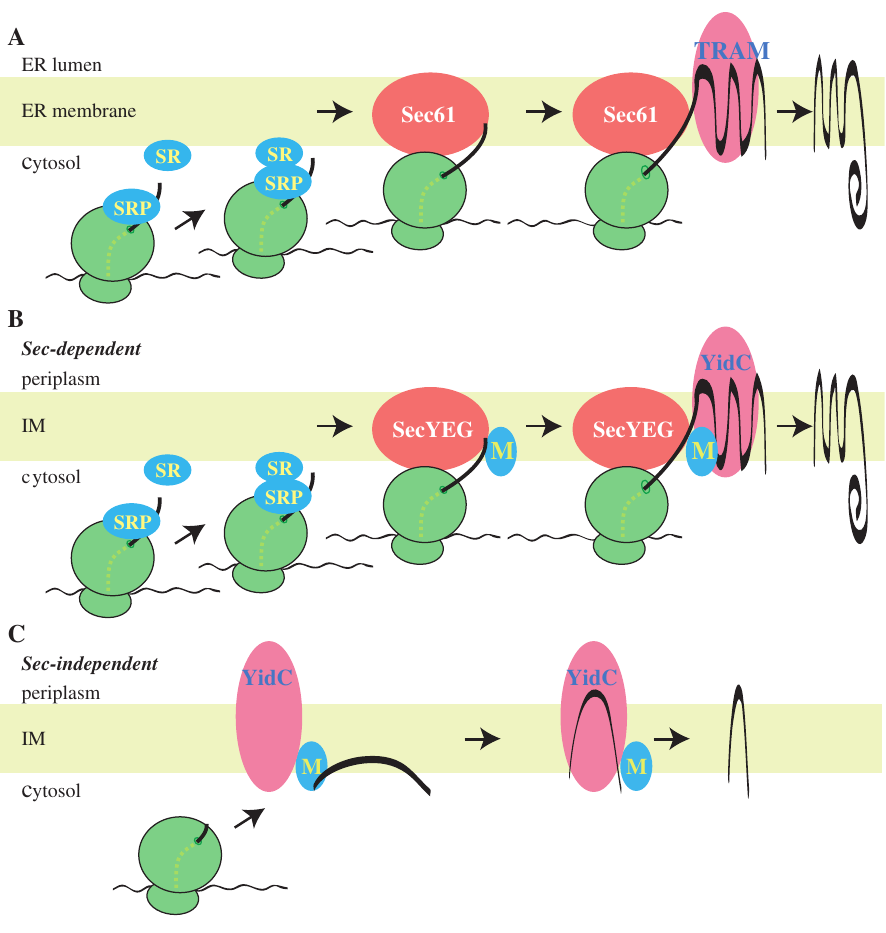
Figure 1 Mechanisms for membrane protein integration. Protein integration into the ER membrane (A) or the cytoplasmic (inner) membrane of E. coli (B and C). The Sec-dependent (B) and -inde- pendent (C) pathways are shown. MPIase is shown as